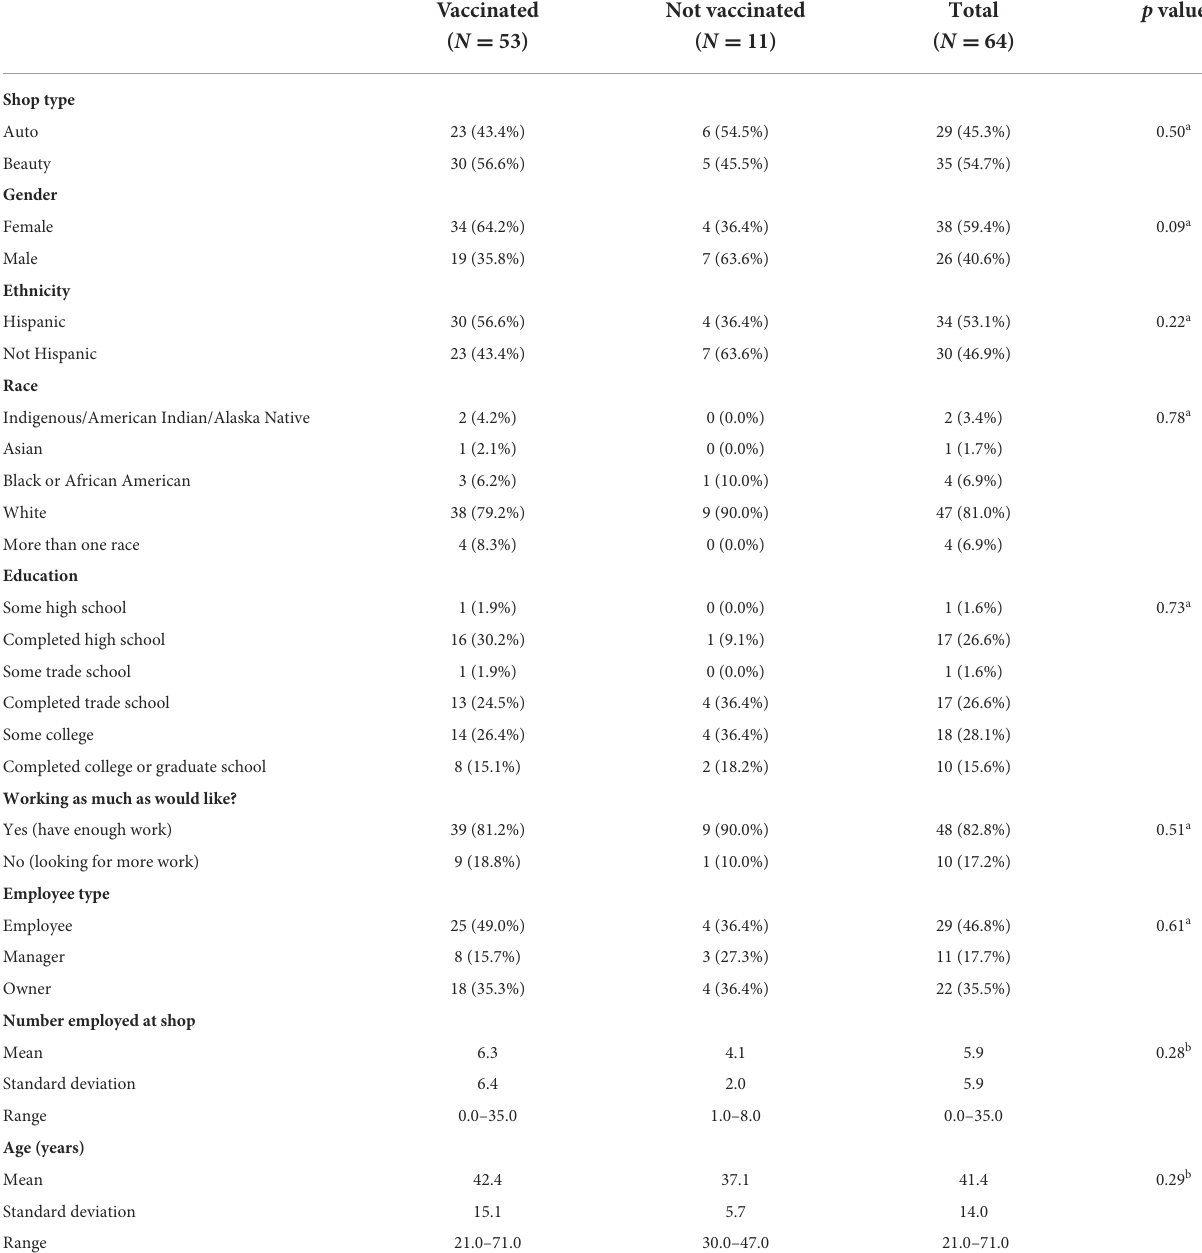
TABLE 2 Descriptive statistics of demographics by vaccination status for our cross-sectional survey of 64 individuals (survey of 67 individuals, three of whom declined to state their vaccination status) between June 8, 2021 and January 25, 2022 who worked at beauty salons and auto shops in Tucson, AZ, were at least 18 years old, and spoke either Spanish or English. Vaccinated Not vaccinated